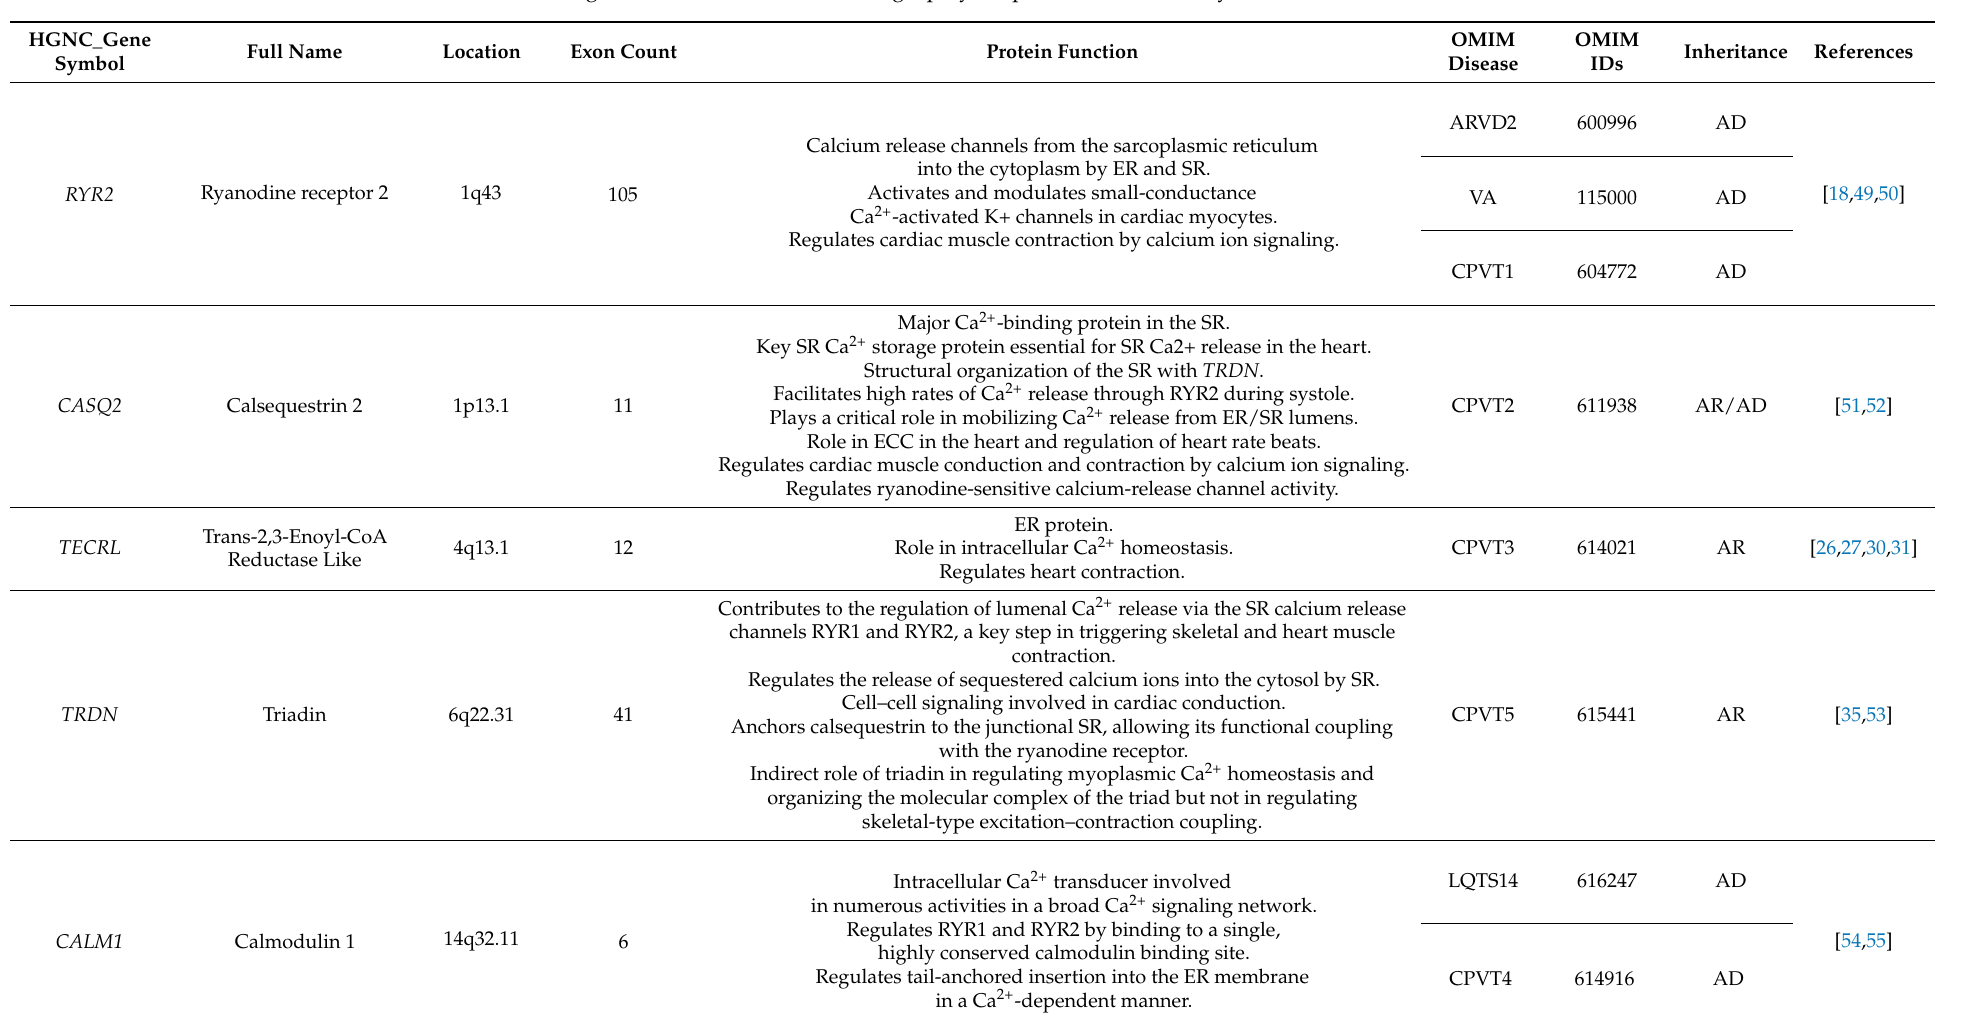
Table 1. Calcium-related genes linked to catecholaminergic polymorphic ventricular